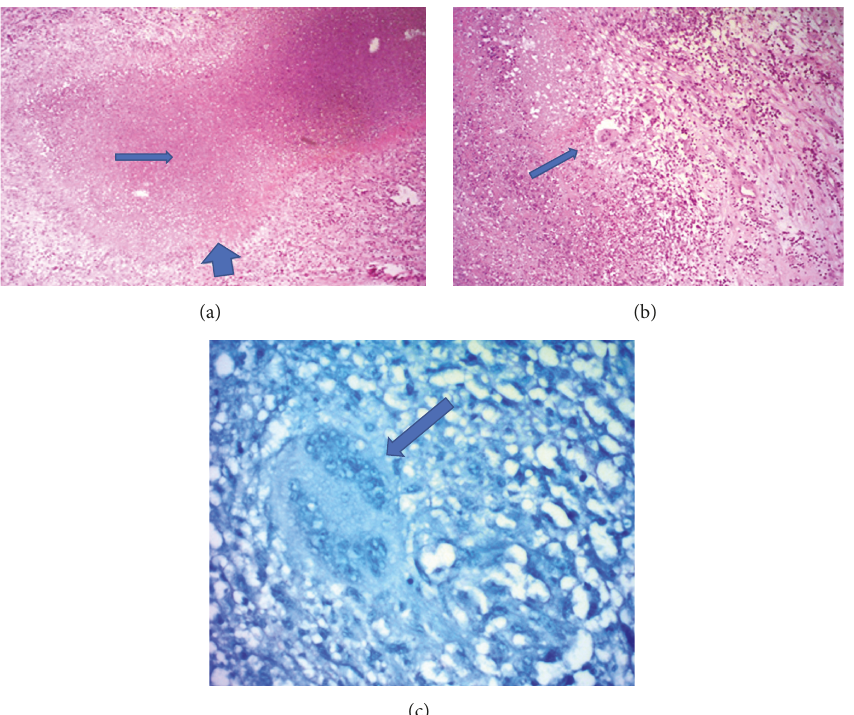
Figure 6: Histological pictures from biopsy specimens of resected mass. (a) Histological appearance of tuberculous granuloma surrounded by palisaded epithelioid histiocytes (broad arrow) with central caseous necrosis (long arrow), (b) magnified histological picture showing a Langhans giant cell (arrow), and (c) Langhans giant cell (arrow) with ZN